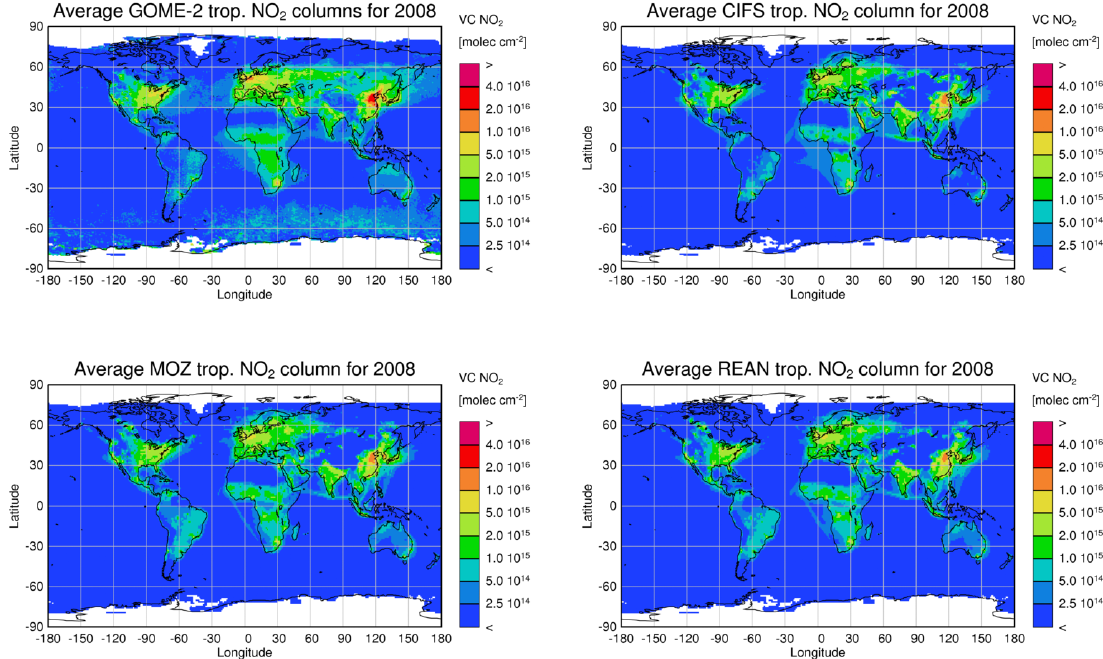
Figure 11. NO 2 tropospheric column retrieval (GOME-2) for 2008 (top left) and by C-IFS (top right), REAN (bottom right) and MOZ (bottom left).